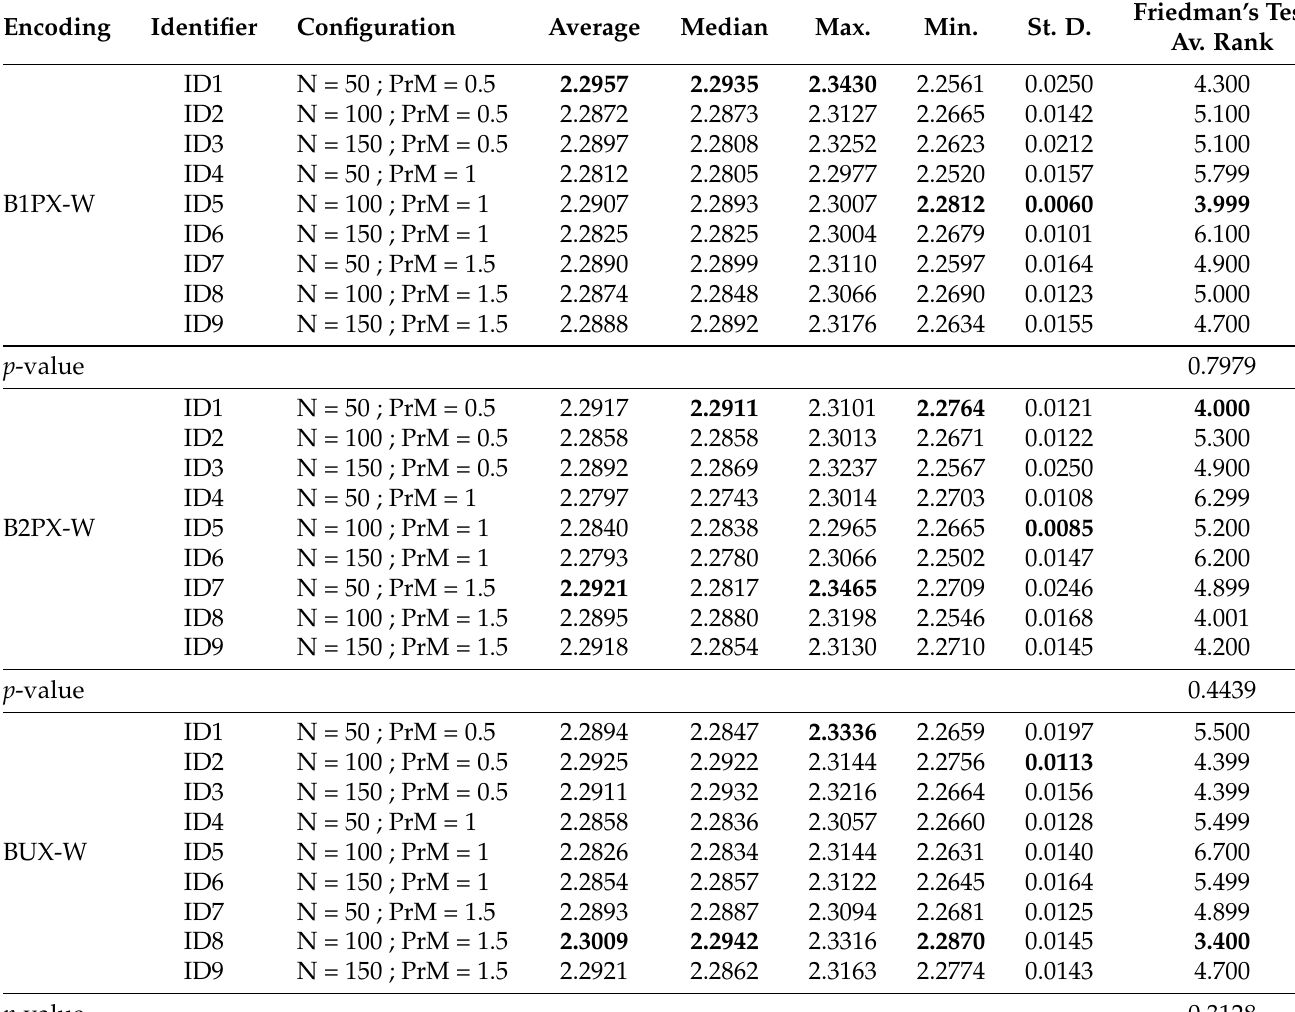
Table 12. Hypervolume statistics (Binary